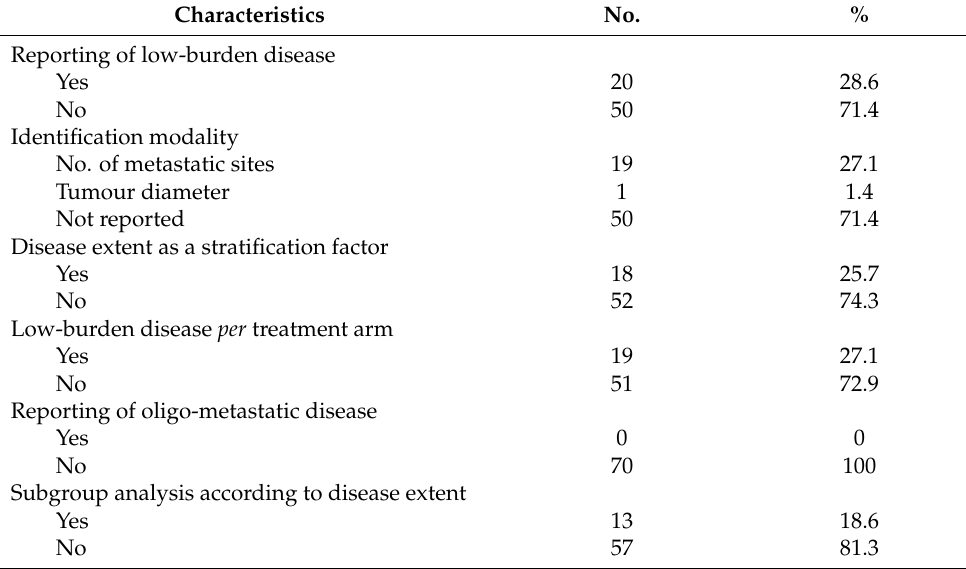
Table 2. Modalities of reporting tumour